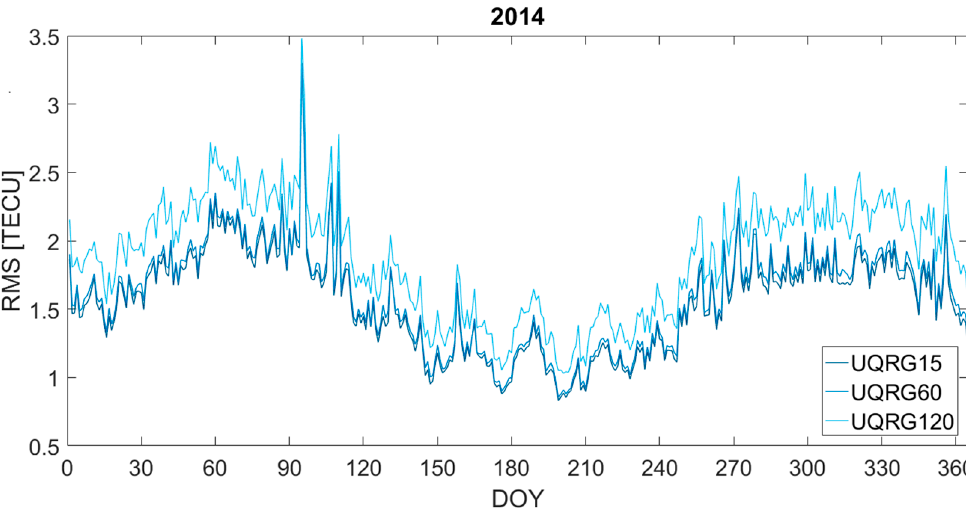
Figure 6. Daily RMS distribution from GNSS-STEC comparisons for all analyzed GIMs in 2014. Table 4. Annual RMS from GNSS-STEC comparisons for all analyzed GIMs in 2014.